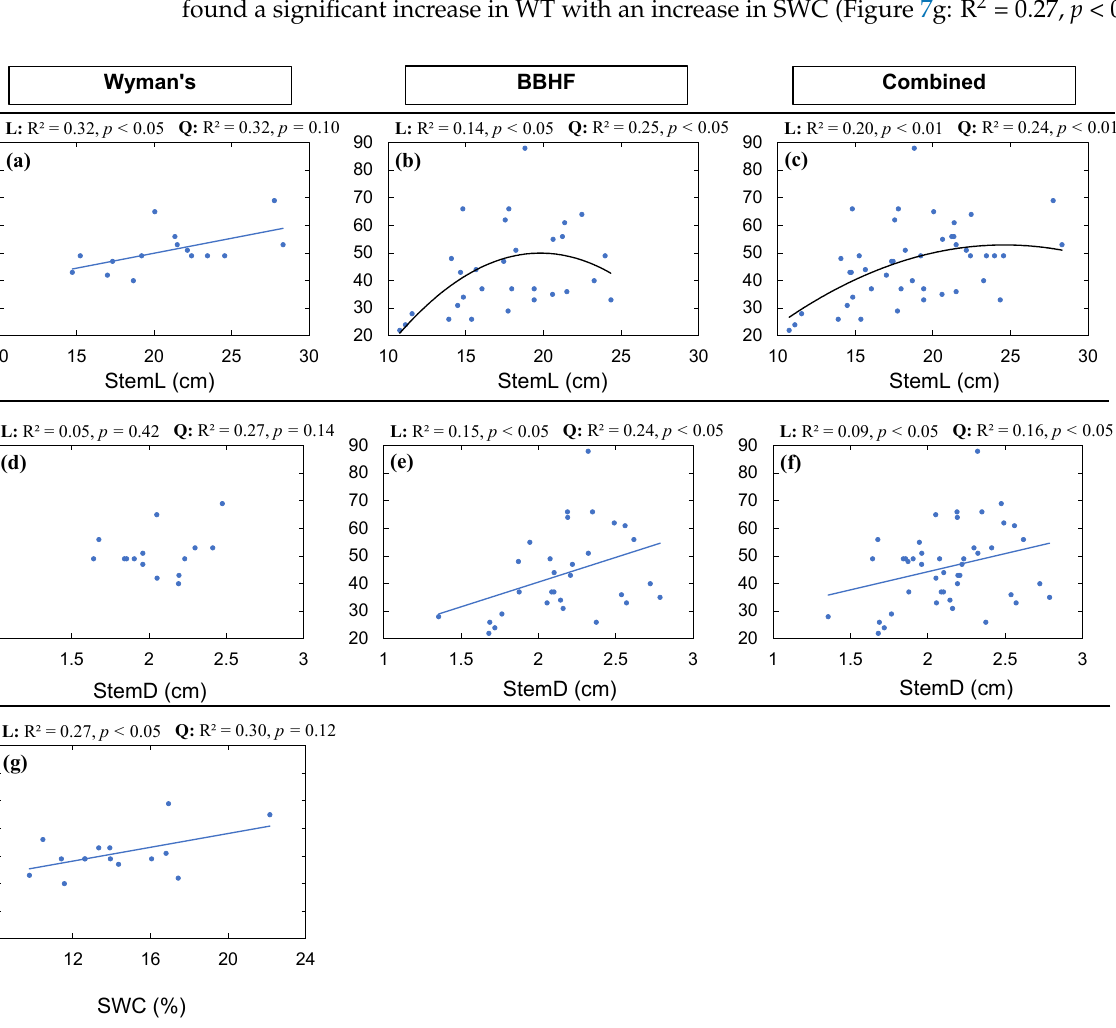
Figure 7. Berry size (weight of 100 berries) (WT) in relation to average stem length (StemL) ( a – c ); average stem diameter (StemD) ( d – f ); and average soil water content (SWC) ( g ). The solid blue lines indicate significant ( p < 0.05) linear relationships, and black lines indicate significant ( p < 0.05) quadratic relationships. Dashed lines indicate marginally significant ( p < 0.10) relationships. Here, among all the structural and functional traits, only significant or marginally significant relationships to WT were plotted. The strongest relationship was selected from the high level of significance ( p -value) and higher coefficient of determination (R²).